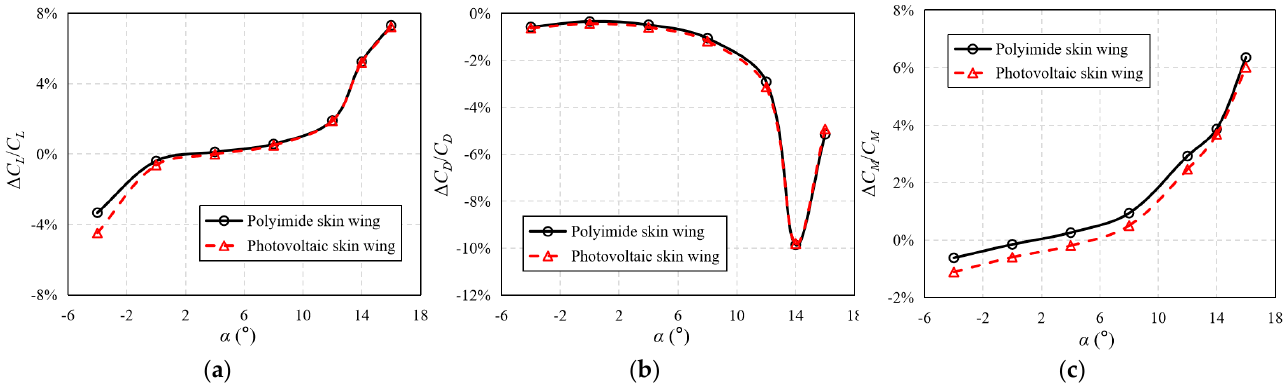
Figure 31. Aerodynamic performance of two kinds of membrane-skin wing: ( a ) Δ C L / C L ; ( b ) Δ C D / C D ; ( c ) Δ C M / C M .